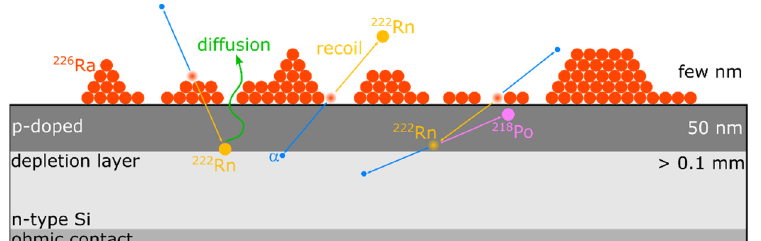
Figure 1. Schematic of silicon detector, modified with a thin layer of 226 Ra (IRSD). The silicon detector is made up of n-type silicon and a p-doped front side contact. Reverse biasing of the p/n-junction results in a depletion layer of several 0.1 mm thickness, which is the sensitive detection volume. The 222 Rn emanation mechanisms of recoiling and diffusion are depicted, as well as the spatial displacement of progeny along the decay chain. Details are given in the